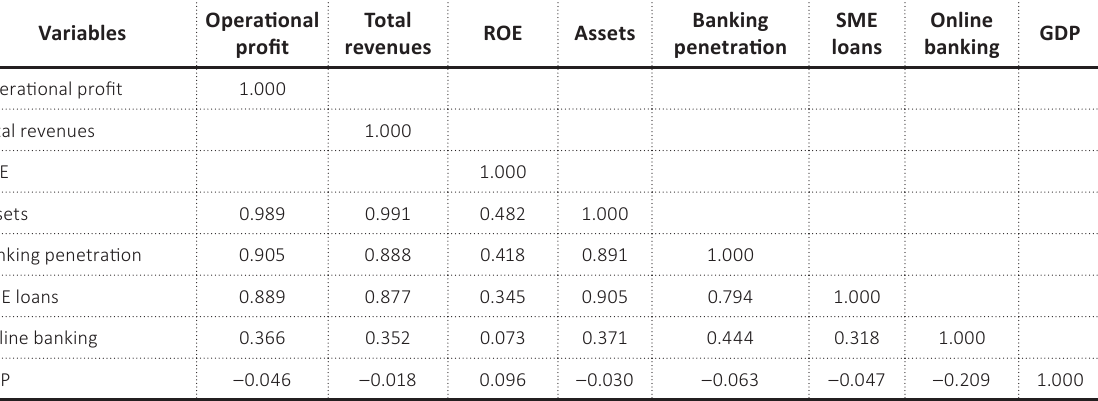
Table 3. Correlation